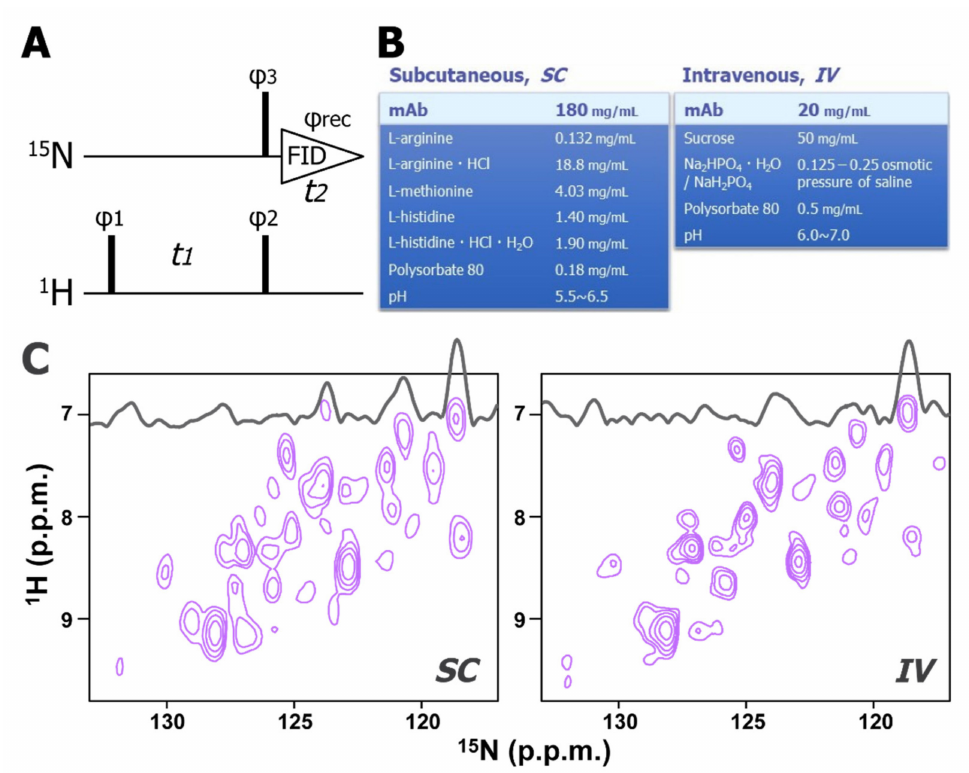
Figure 3. Two-dimensional 15 N-detected CRINEPT spectra of mAb in formulated storage condi- tion. ( A ) The pulse sequence of the 15 N-detected CRINEPT experiment. Narrow bars indicate π /2 hard pulses. The phase cycles employed were ϕ 1 = (x − x), ϕ 2 = y, ϕ 3 = (x − x − x − x), and ϕ rec = (x − x − x − x). Phase-sensitive acquisition in the indirect 1 H dimension is achieved by incrementing the phase ϕ 1 in a STATES-TPPI manner [71]. ( B ) Examples of formulation condition for subcutaneous injection (SC; left), and intravenous injection (IV; right) ( C ) The 15 N-detected CRINEPT spectra of the mAb in the SC (left) and IV (right) formulations. These spectra were acquired at 4 ◦ C. The figure is reproduced from